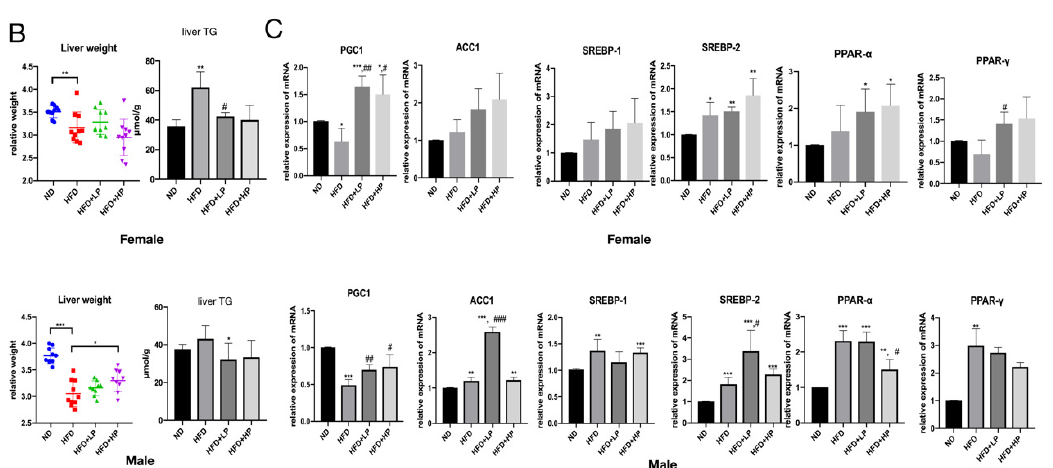
Figure 3. CP application prevented liver steatosis and promoted liver lipid metabolism in HFD-fed mice. ( A ) Liver Oil Red O staining of each group in both female and male mice. Each bar: 50 μ m in original photo; 20 μ m in enlarged photo. ( B ) Liver TG concentration and liver weight were changed according to the diet. ( C ) The relative expression of PGC1 , ACC1 , SREBP1/2 , and PPAR ɑ / γ mRNA in liver, and were normalized with GADPH ( n = 8). Values are presented as the mean ± SD.